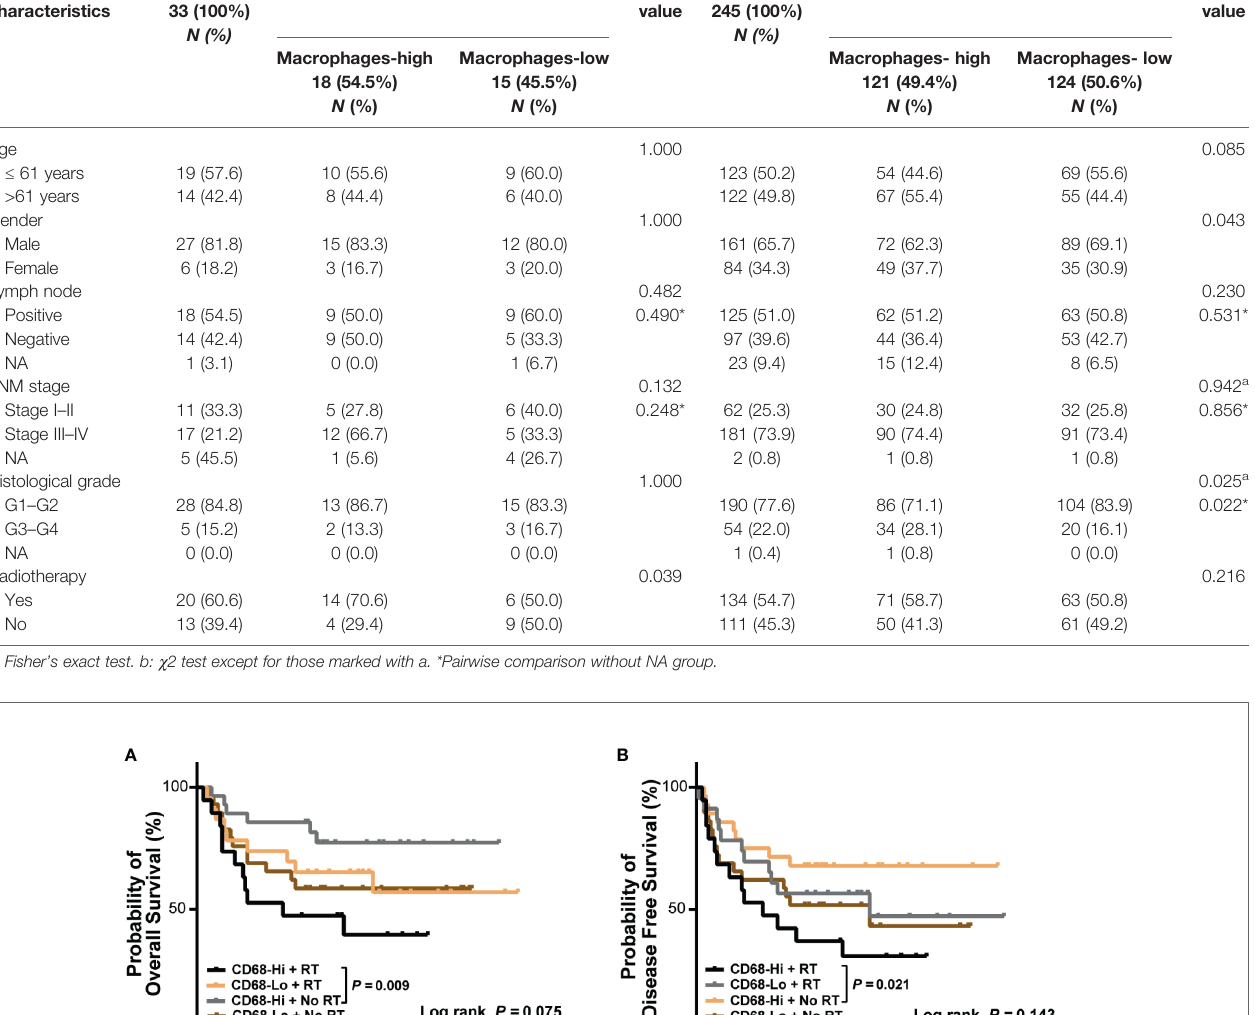
TABLE 4 | Correlation of macrophage in fi ltration deconvolved using EPIC with clinic-pathological characteristics of HPV positive and negative OSCC patients in TCGA cohort. Clinic-pathological characteristics